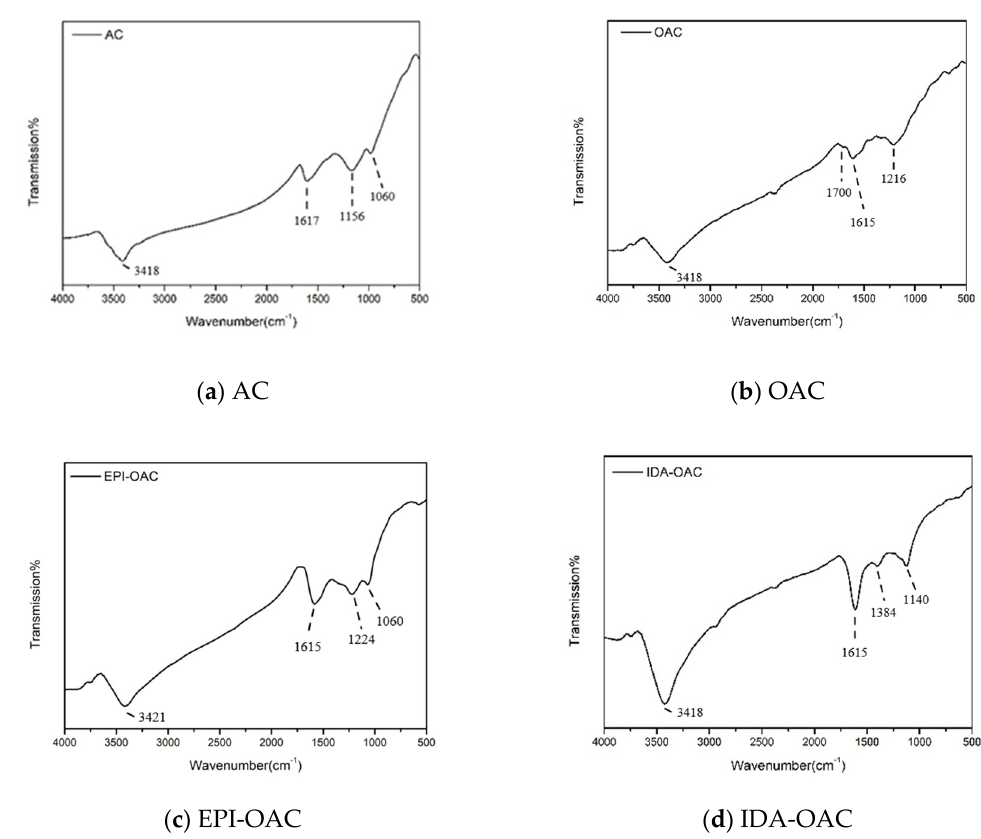
Figure 1. FT-IR spectrum of AC, OAC, EPI-OAC and IDA-OAC. Table 1. Element analysis of AC, OAC, and